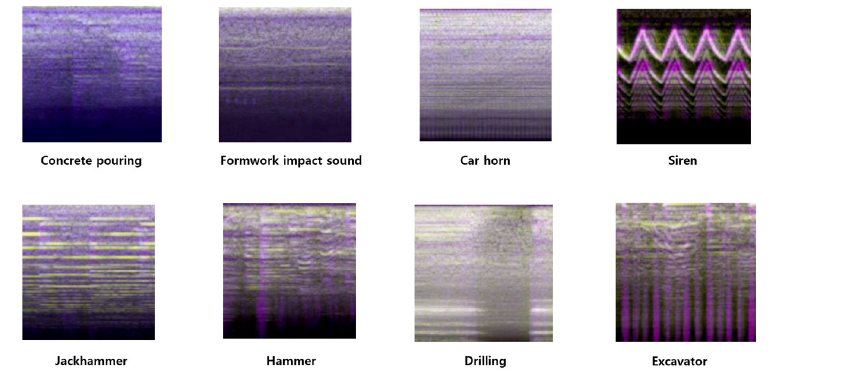
Figure 10. Recurrent neural networks (RNNs).